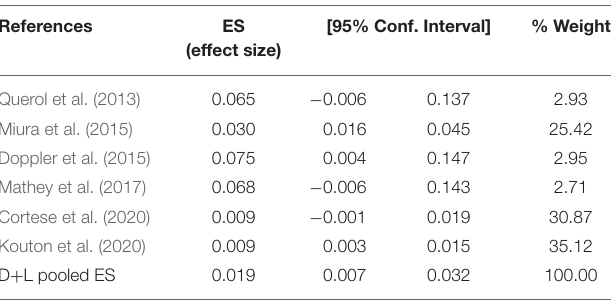
Frontiers in Neuroscience |